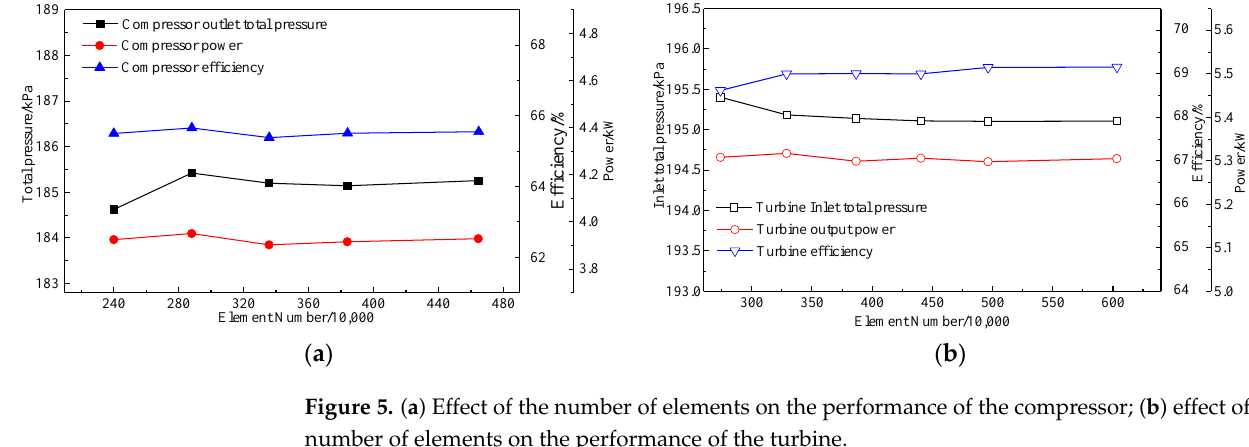
Figure 5. ( a ) Effect of the number of elements on the performance of the compressor; ( b ) effect of the number of elements on the performance of the turbine.